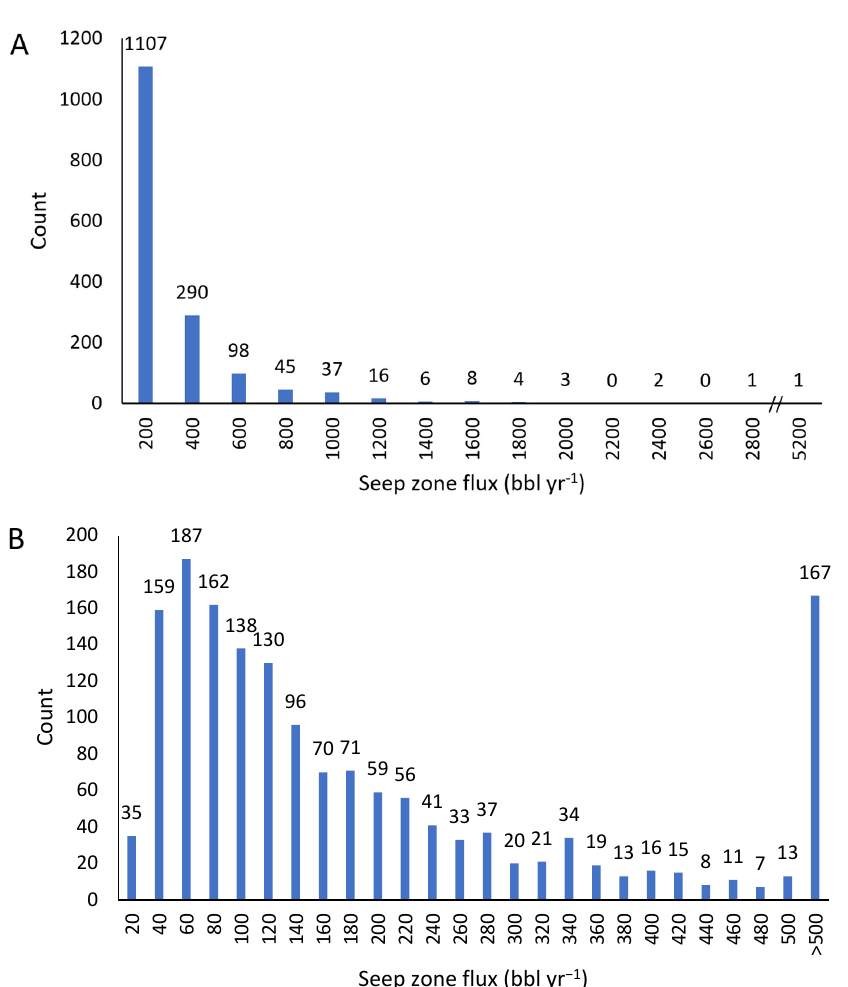
Figure 10. Comparison of seep zone depth to seep zone average flux. Inset enlarged to show lack of relationship between depth and average flux of seep zones.